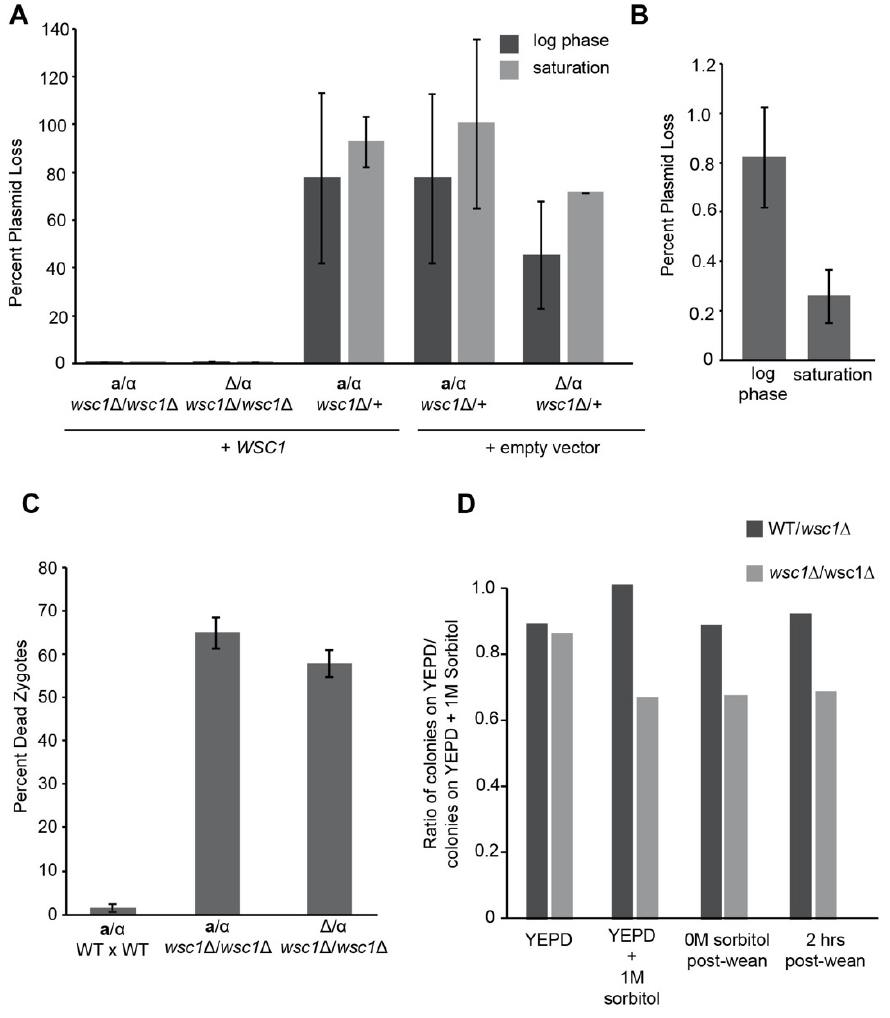
Figure 5. WSC1 is necessary for diploid growth. ( A – C ) WSC1 dependency is independent of mating type and exacerbated by stationary phase. ( A ) The following strains were transformed with a URA3 centromeric empty vector plasmid or with the same plasmid bearing WSC1 : a/ α WT/ wsc1 ∆ empty vector (MY16050), a/ α WT/ wsc1 ∆ + WSC1 (MY16049), a/ α wsc1 ∆ / wsc1 ∆ , ∆ / α WT/ wsc1 ∆ empty vector (MY16052), ∆ / α WT/ wsc1 ∆ + WSC1 (MY16051), and ∆ / α wsc1 ∆ / wsc1 ∆ + WSC1 (MY16053). Cells were grown in YEPD liquid log phase (O.D. 0.4–0.7) or saturation and plated on both YEPD plates and 5-FOA plates to quantify plasmid loss. Colonies were counted after two days at 30 °C. ( B ) WSC1 plasmid loss in a/ α wsc1 ∆ / wsc1 ∆ during log phase or stationary phase. Experiments were performed three times independently. Error bars represent the standard error of the mean for both A and B. One-tailed Student’s t-test was used to determine significance. ( C ) Filter matings of WT x WT (MY8092 x MY8093), wsc1 ∆ x wsc1 ∆ (MY14305 x MY14306) or mat ∆ wsc1 ∆ x MAT α wsc1 ∆ (MY16045 x MY14306) were performed for 3 h at 30 °C. Cells were resuspended in TAF buffer, stained with FM4-64, and imaged. n ≥ 100 cells for each. Error bars represent the standard error of the mean. Chi-squared statistical tests were used to determine significance. ( D ) wsc1 ∆ /wcs1 ∆ diploid cells adapt to growth without osmotic support. WT/ wsc1 ∆ (MY15803) or wsc1 ∆ / wsc1 ∆ (MY15805) diploids were grown continuously in YEPD (left most bars) or in YEPD + 1 M sorbitol. The concentration of sorbitol in the media was dropped by 0.2 M every two hours until cells were in 0M sorbitol media when they were plated on YEPD or YEPD + 1 M sorbitol. Cells were allowed to double once without sor- bitol and plated as before. Colonies were counted after 2 days at 30 °C and plotted as a ratio of cells on YEPD plates over cells on YEPD + 1 M sorbitol plates. One representative experiment is shown, based on three technical replicates.